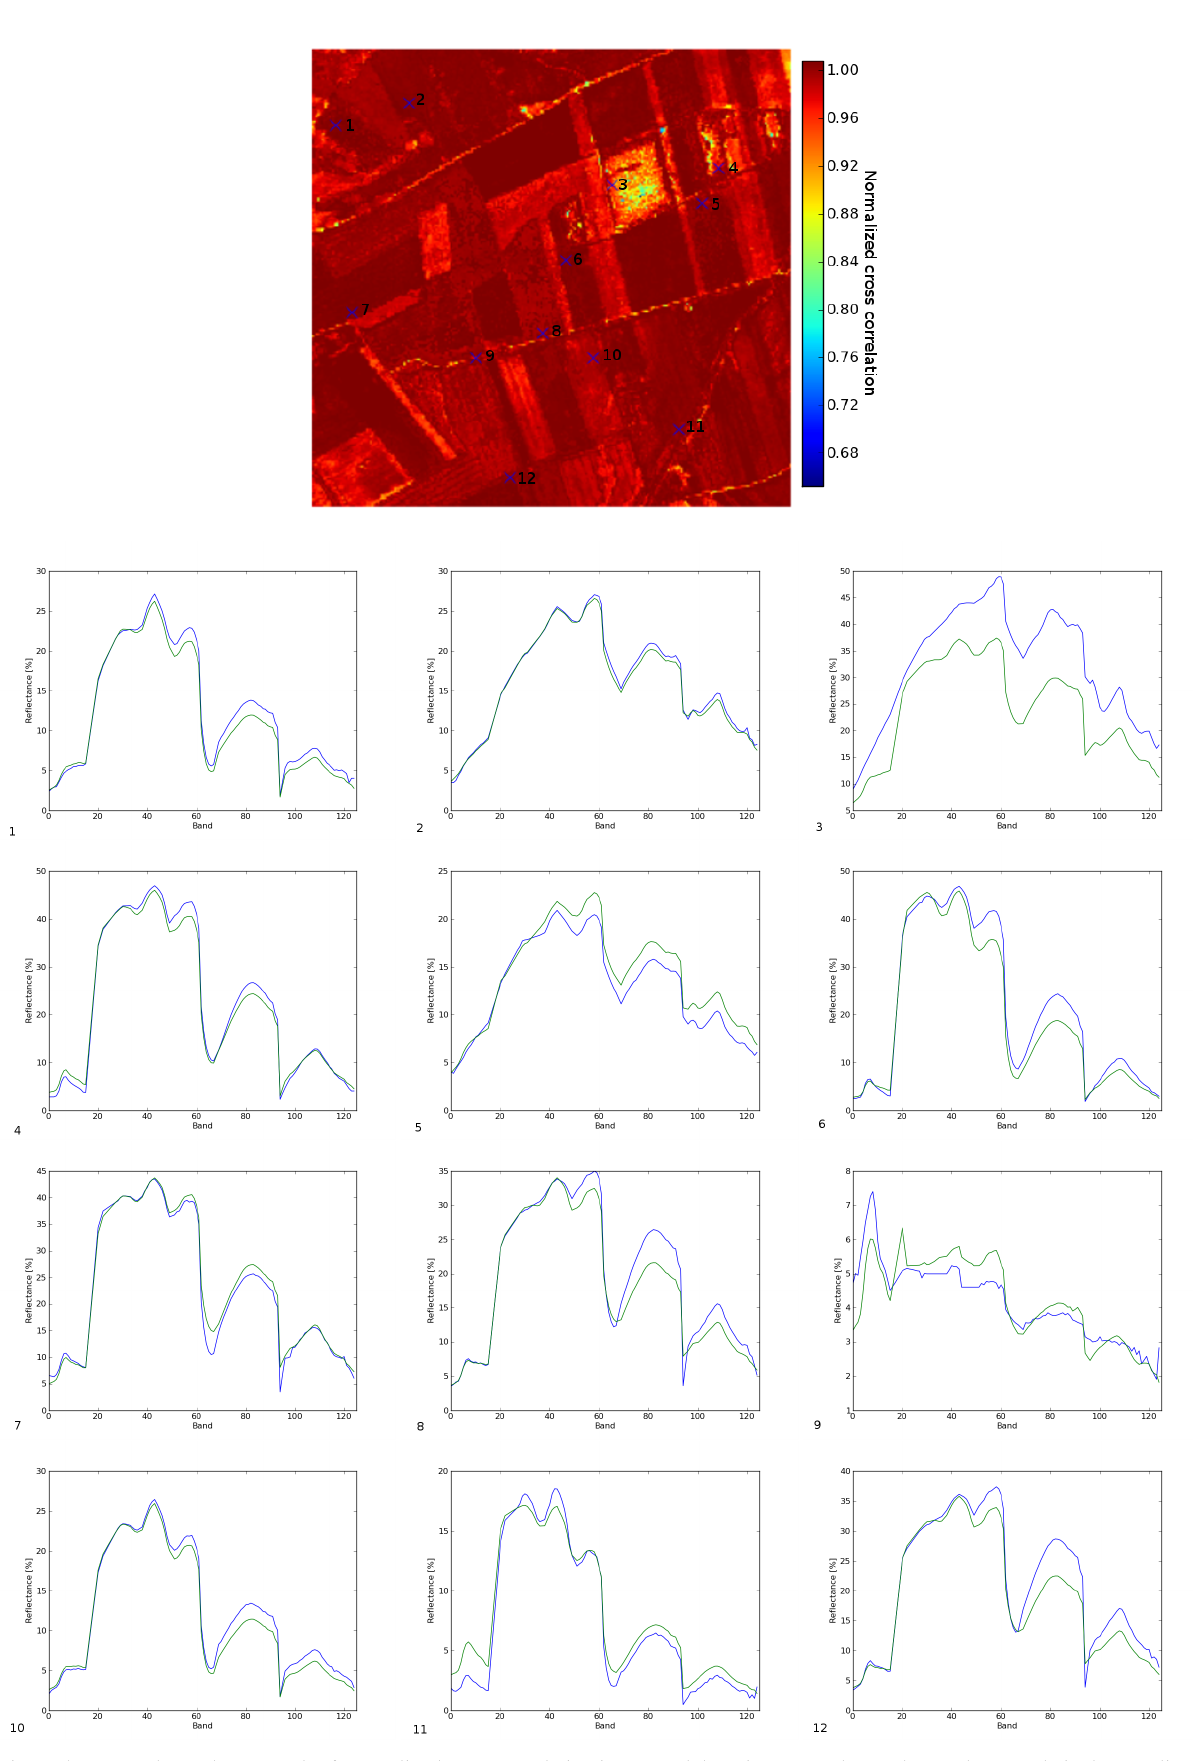
Figure 4: Image above shows result of normalized cross correlation in spectral domain. For each template and restored pixel normalized cross correlation is calculated across all bands. From pixels numbered (1-12) spectral curves are plotted. Reference image (blue lines), restored image (green